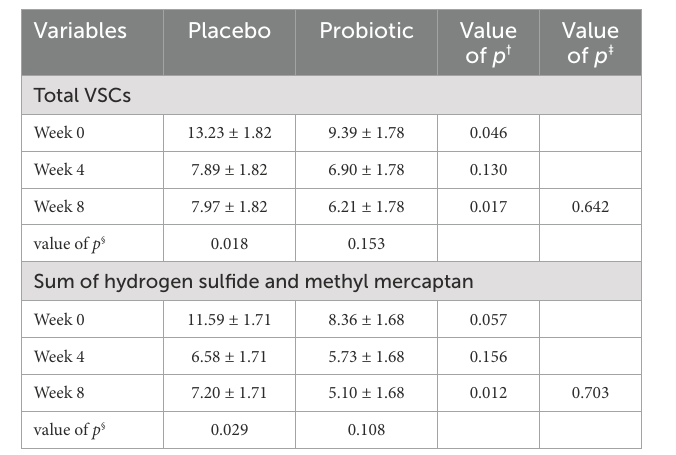
TABLE 2 Total volatile sulfur compound and sum of H 2 S and CH 3 SH at 0(baseline), 4, and 8 weeks (unit: ng/10 ml).